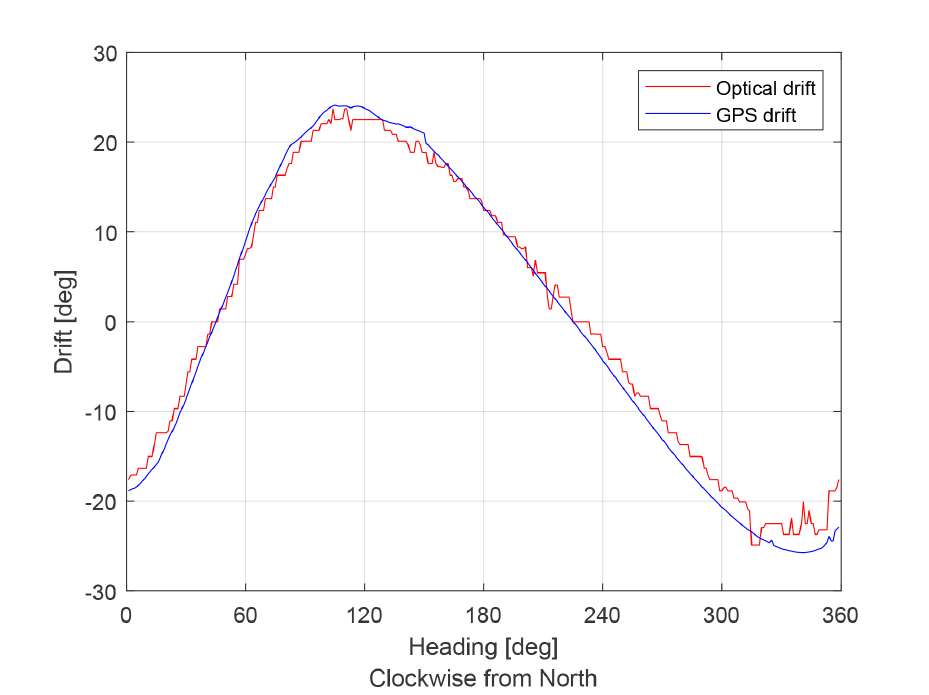
Figure 10. Simulation results. Comparison Global Navigation Satellite System (GNSS) drift and optical estimated